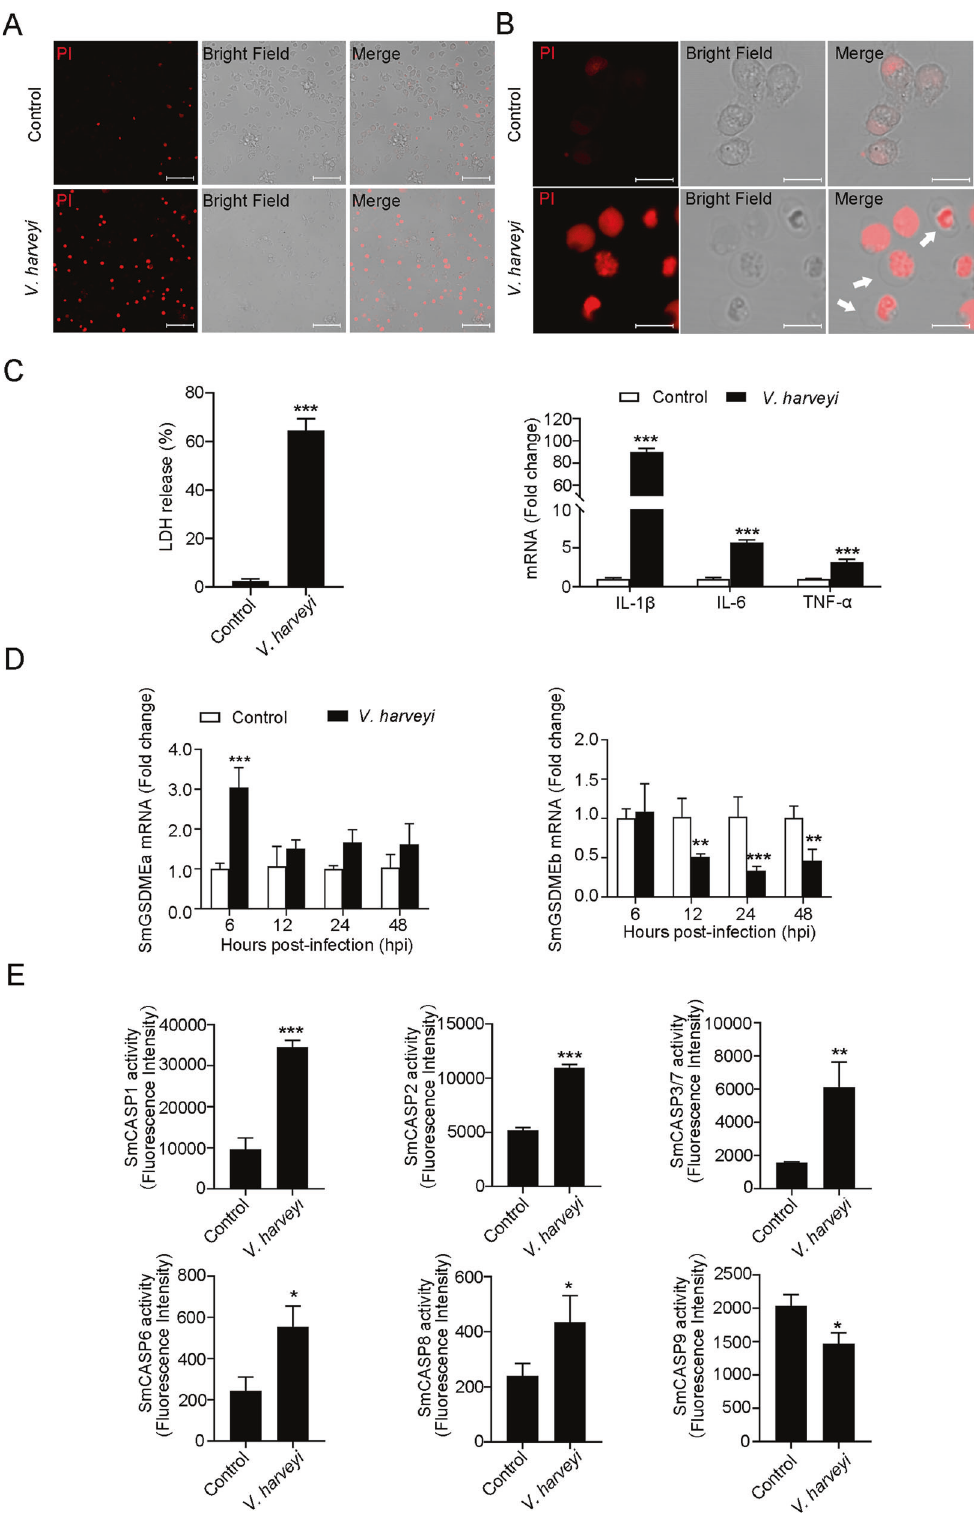
Fig. 1 Vibrio harveyi infection induces necrotic cell death and alters SmGSDME expression and SmCASP activity. A , B Macrophages from V. harveyi -infected turbot were observed for PI uptake and morphological features of cell death. White arrows indicate cell death with swelling. Scale bars, 40 ( A ) and 10 ( B ) μ m. C Turbot macrophages were infected with V. harveyi for 6 h and then measured for LDH release (left) and proin fl ammatory cytokine expression (right). D Turbot were infected with or without (control) V. harveyi , and SmGSDMEa and SmGSDMEb expression in kidney was determined by qRT-PCR at various time points. E Macrophages from V. harveyi -infected turbot were examined for SmCASPs activities. In all bar graphs, data represent the means ± SD, n = 3. *** P < 0.001; ** P < 0.01; * P < 0.05.